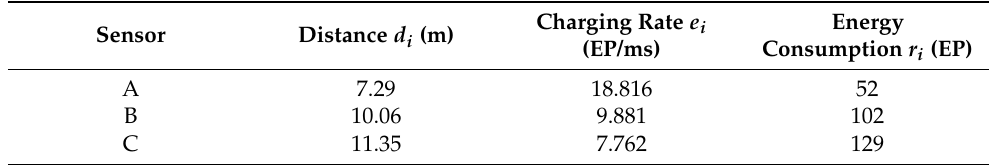
Table 2. Parameters of wireless sensors A, B, and C.